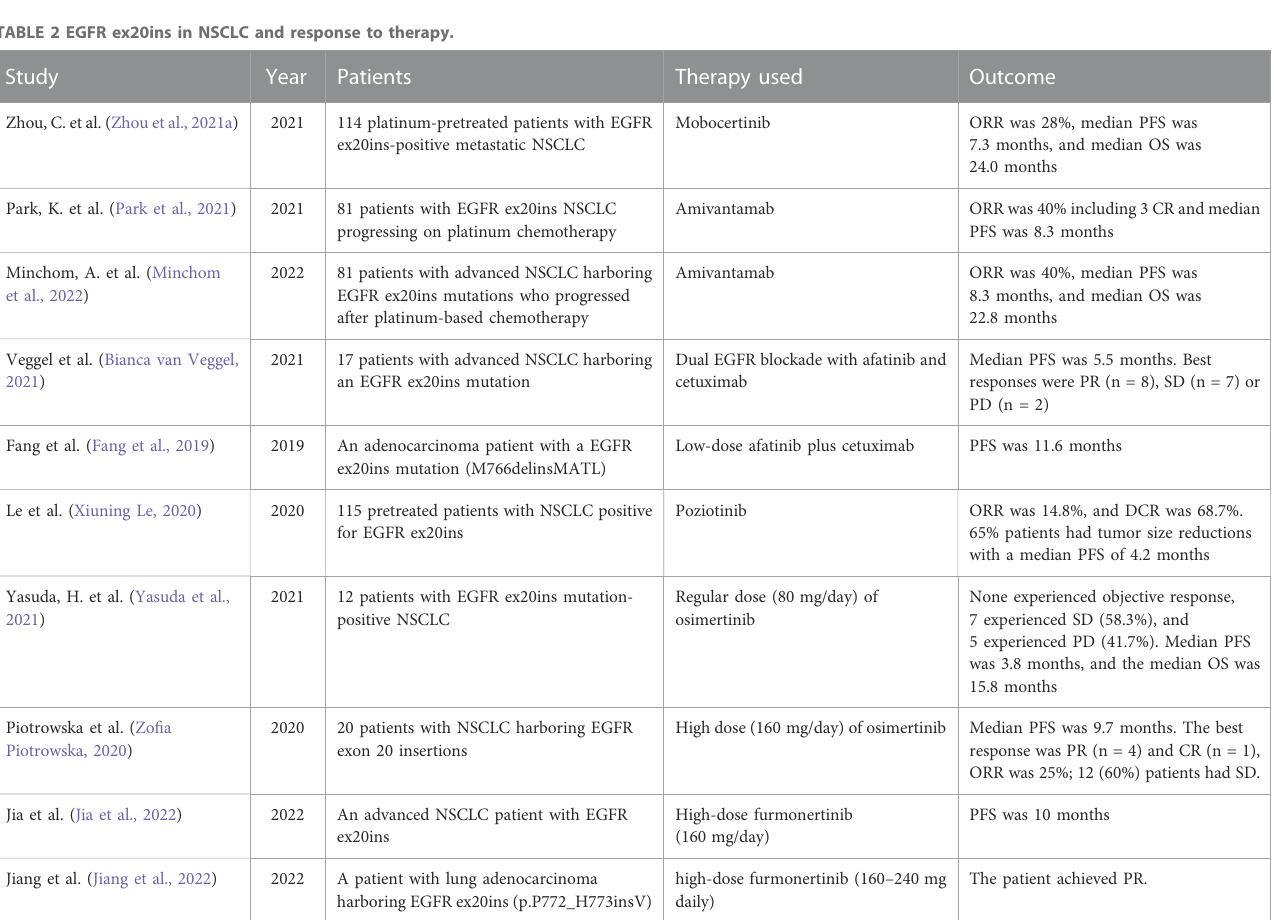
TABLE 2 EGFR ex20ins in NSCLC and response to